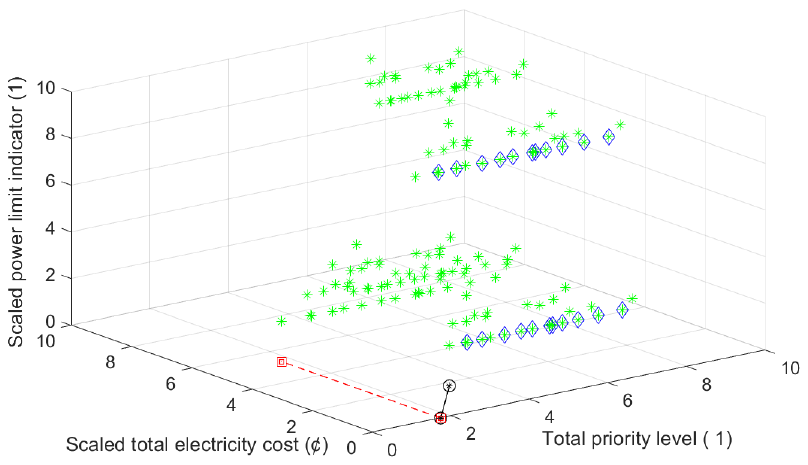
Figure 10. Three-axis chart for possible triplets of ( t wm s , t dw s , t bp s ) for Scenario 2. In the considered day, through the possible triplets of starting times, triplets with the cheapest cost (16.40 cent), their priority level values and power limit indicator values are given in Table 12 and indicated by blue diamond on the chart in Figure 10. For some of these triplets, the power limit is exceeded. For one of these triplets corresponding daily total power consumption graph is given Figure